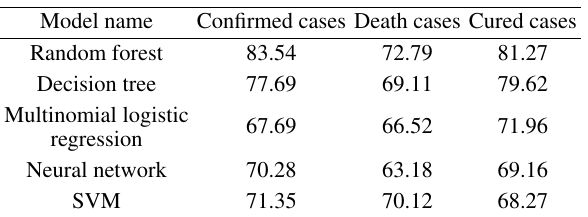
Table 4 Multi-class classification accuracy calculated by various machine learning models.